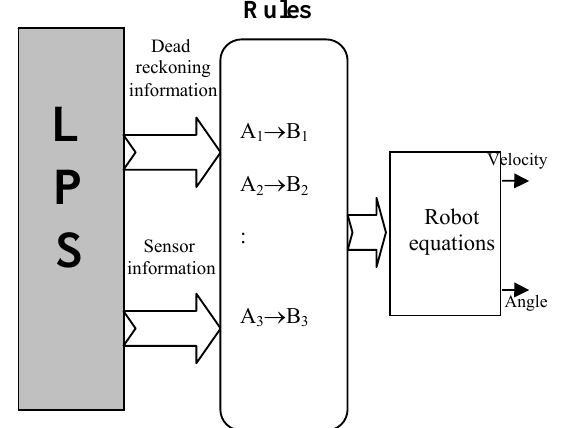
Fig. 12. Behavioral Rules provide true angle and velocity set points for the